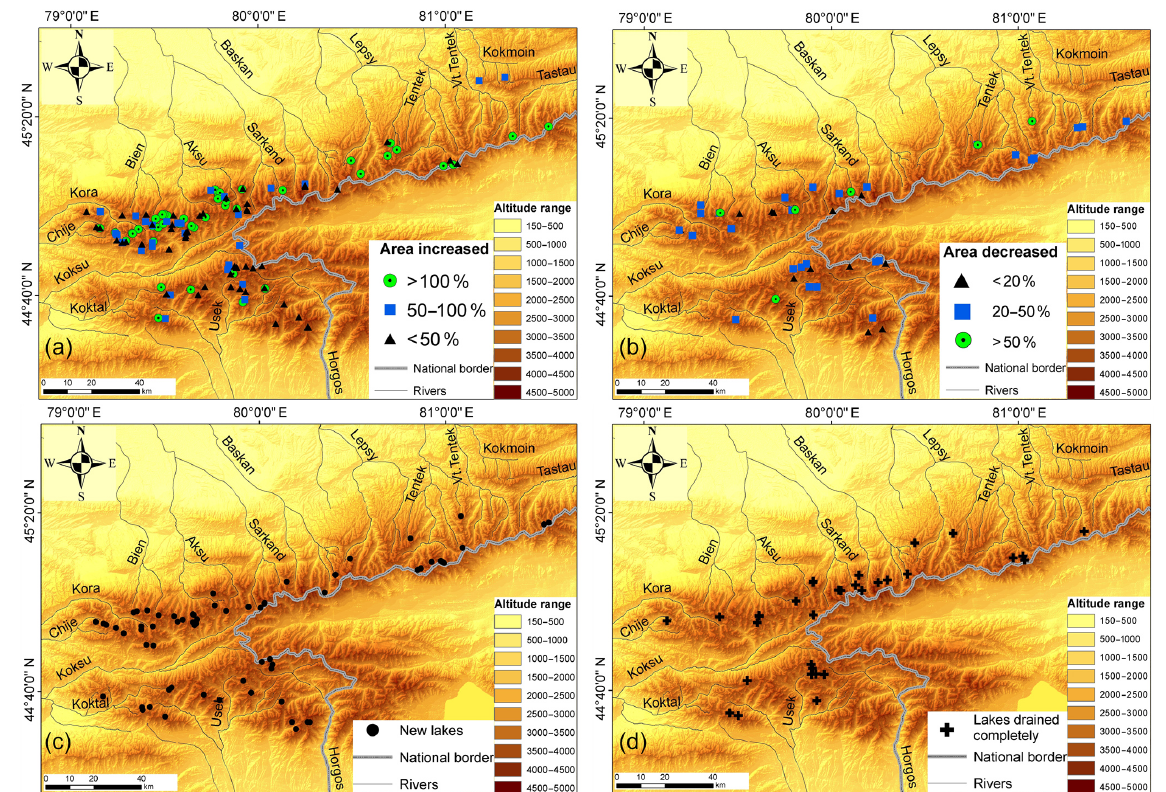
Figure 8. Spatial distribution of lakes which (a) increased in size, (b) decreased in size, (c) newly formed and (d) drained